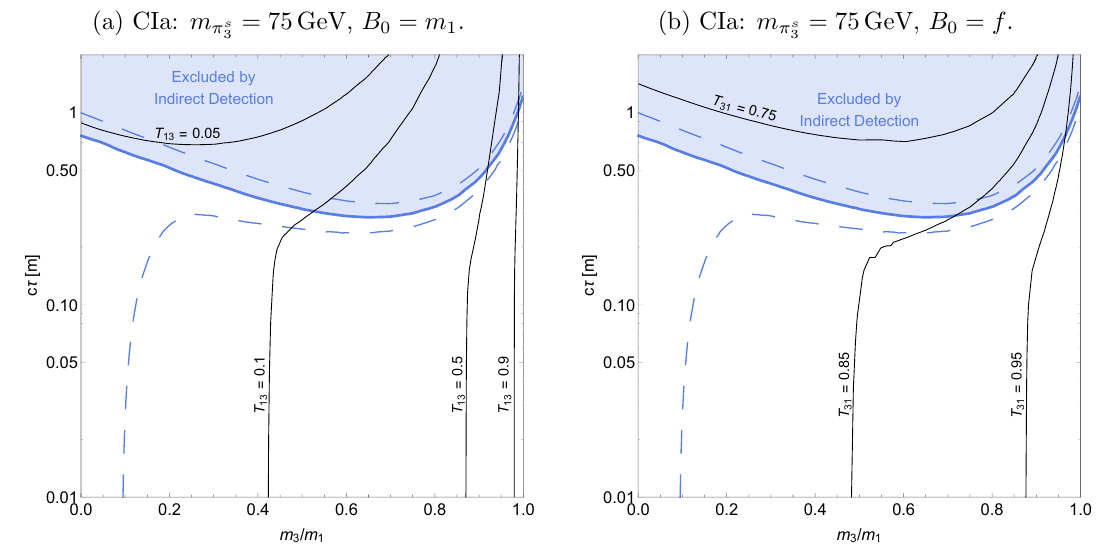
Figure 11. Allowed region of parameter space for the benchmark CIa for (a) B 0 = m 1 and (b) B 0 = f . The blue region is excluded by indirect detection. The black contour lines represent constant values of T 13 (a) or T 31 (b). The dashed blue lines correspond to what the exclusion limit from indirect detection would be if the limit on the e(cid:11)ective cross section were to vary by (cid:6)